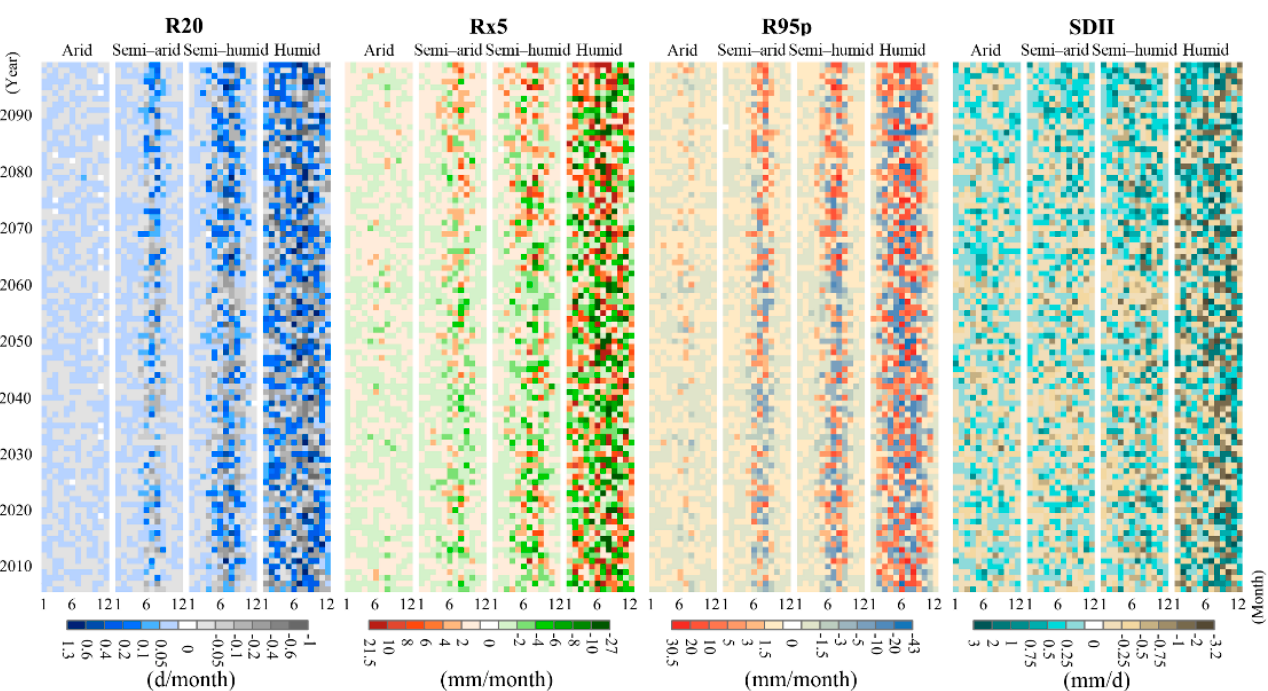
Figure 8. Spatial distribution of multi-year mean monthly precipitation indices and percentage differences between RCP4.5 and RCP8.5 scenarios in 2006–2099. (The calculation formula of percentage difference is (P RCP8.5 − P RCP4.5 )/P RCP4.5 ×